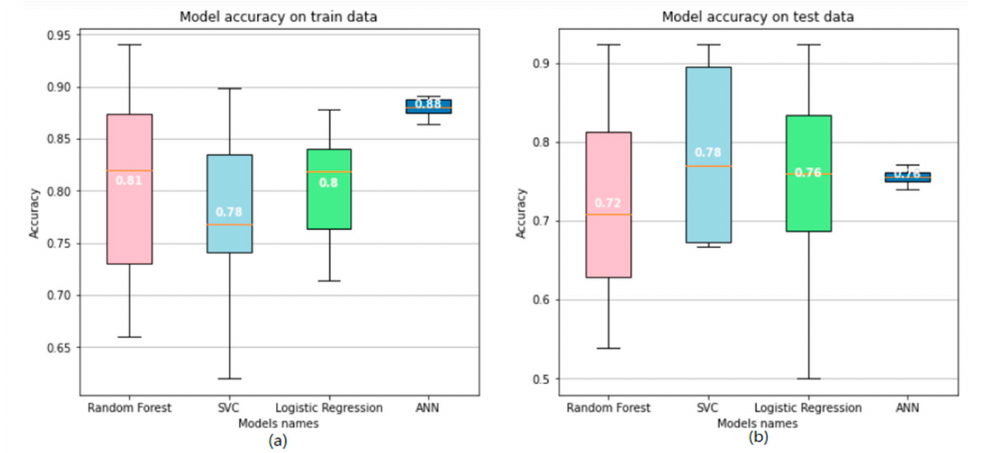
Figure 5. Accuracy of the models on the decreased dataset. ( a ) demonstrates the accuracy of the models on train data and ( b ) demonstrates the accuracy of the models on test data. On the right-hand side of Figure 5, the accuracy of the models on training data with Ranking 1 is shown. The length of the boxes is long and the results of the model (cid:48) s performance on the decreased dataset have a more diverse range than the results on the original dataset. The average accuracy value of the SVM model has the most change